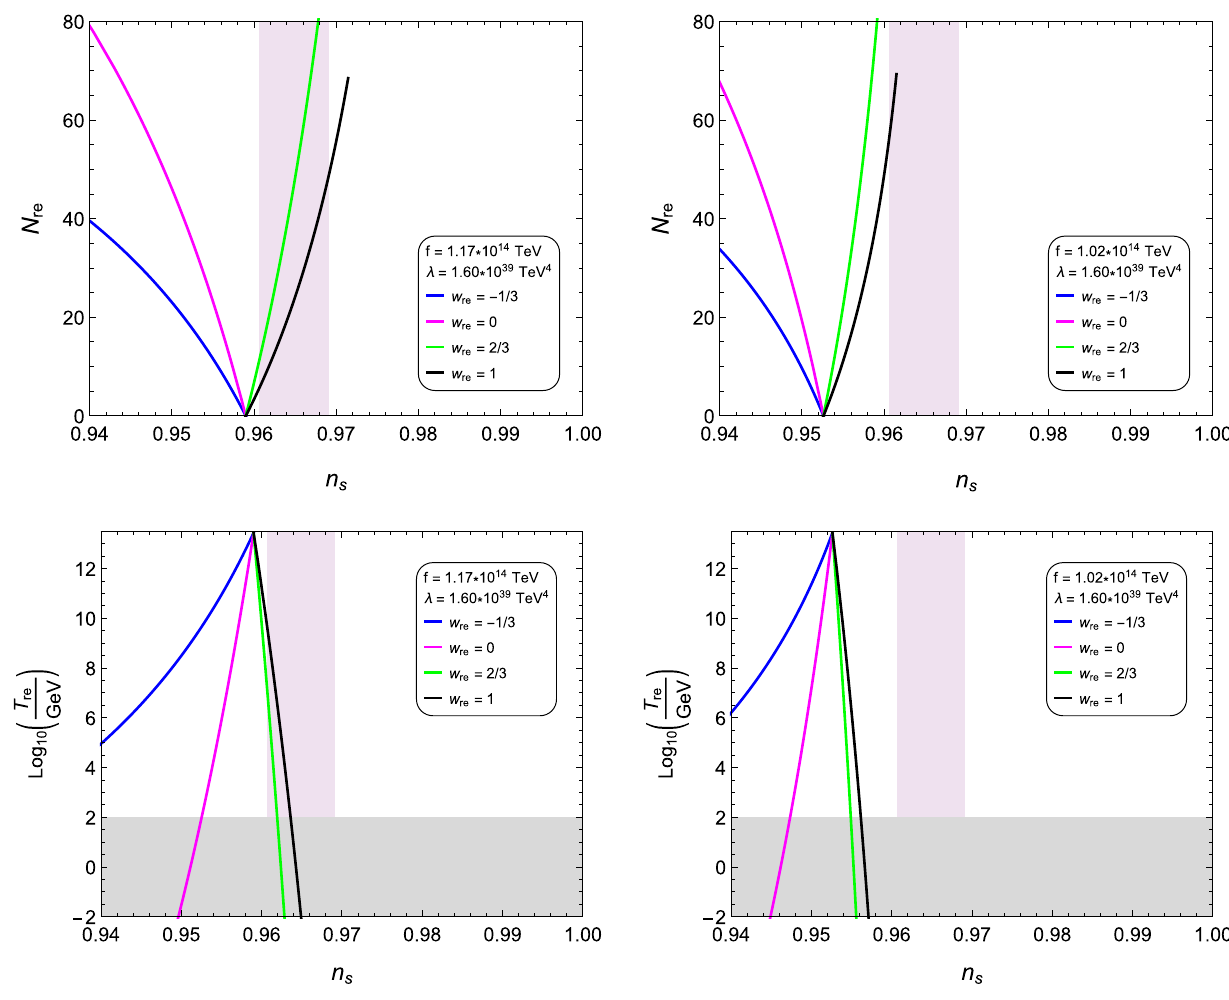
Fig. 4 Same as Fig. 3 but for the upper limit of the five-dimensional Planck mass, M 5 = 10 12